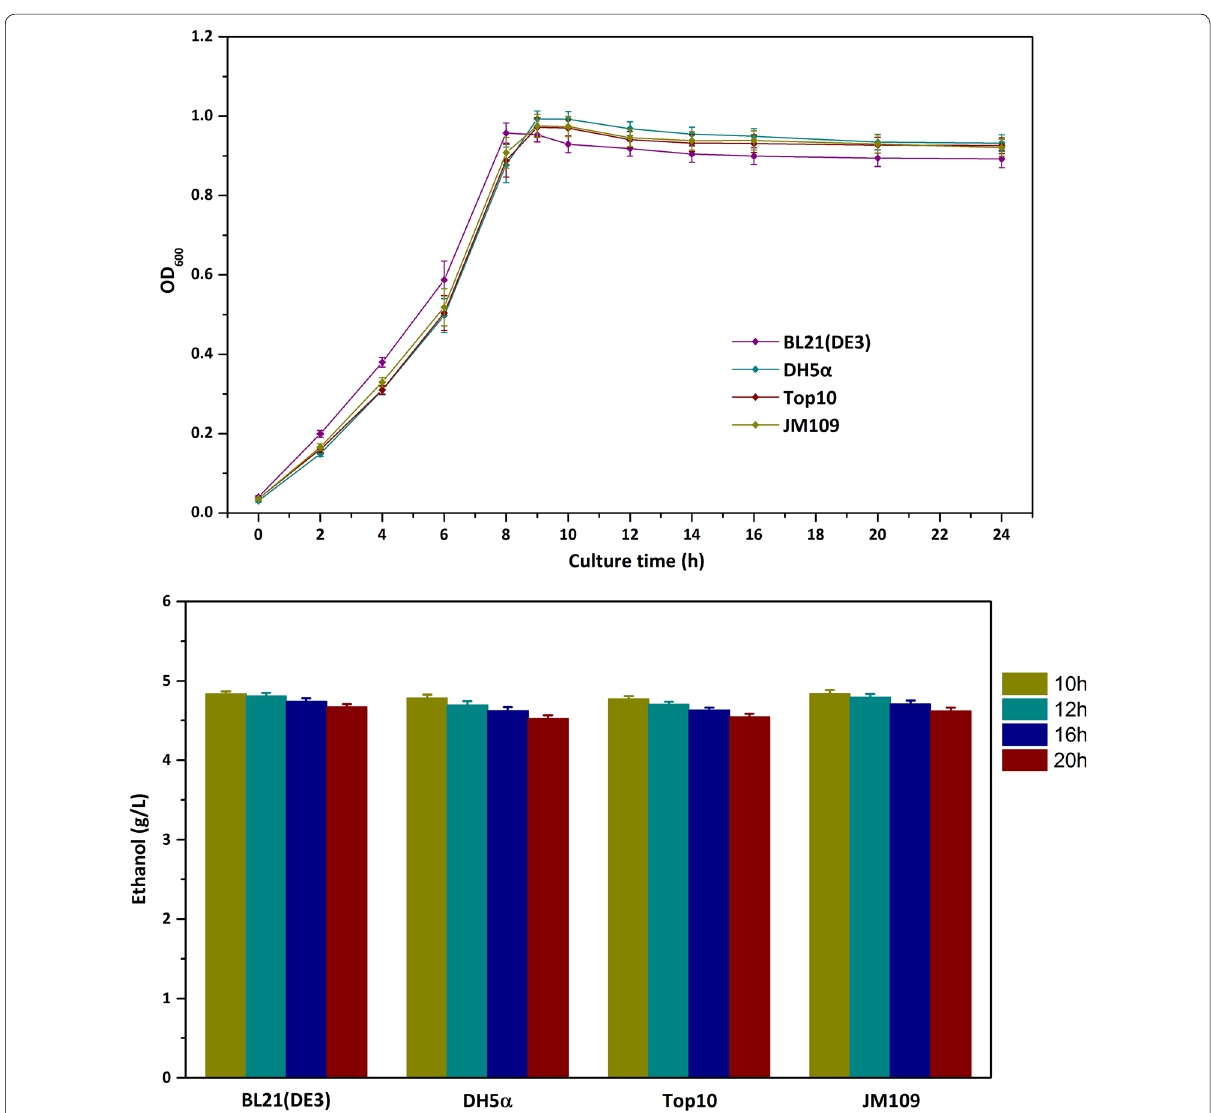
Fig. 2 Growth curves and ethanol utilization of commonly used E. coli strains. a Growth curves of strains BL21(DE3), DH5α, Top10 and JM109; b residual ethanol concentrations in the fermentation broth of strains BL21(DE3), DH5α, Top10 and